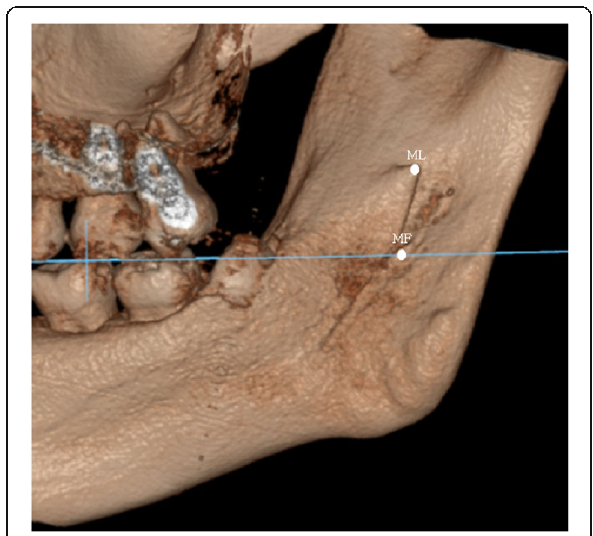
Fig. 4 ML above the occlusal plane; MF at the level of occlusal plane. The blue line indicates the occlusal plane